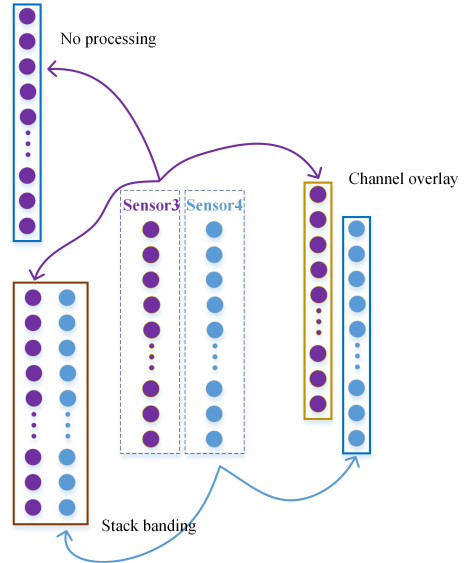
Figure 7. Three different methods of data